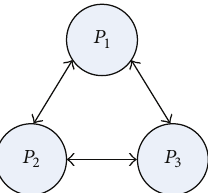
Figure 2: A fully connected parallel system with 3 heterogeneous processors.